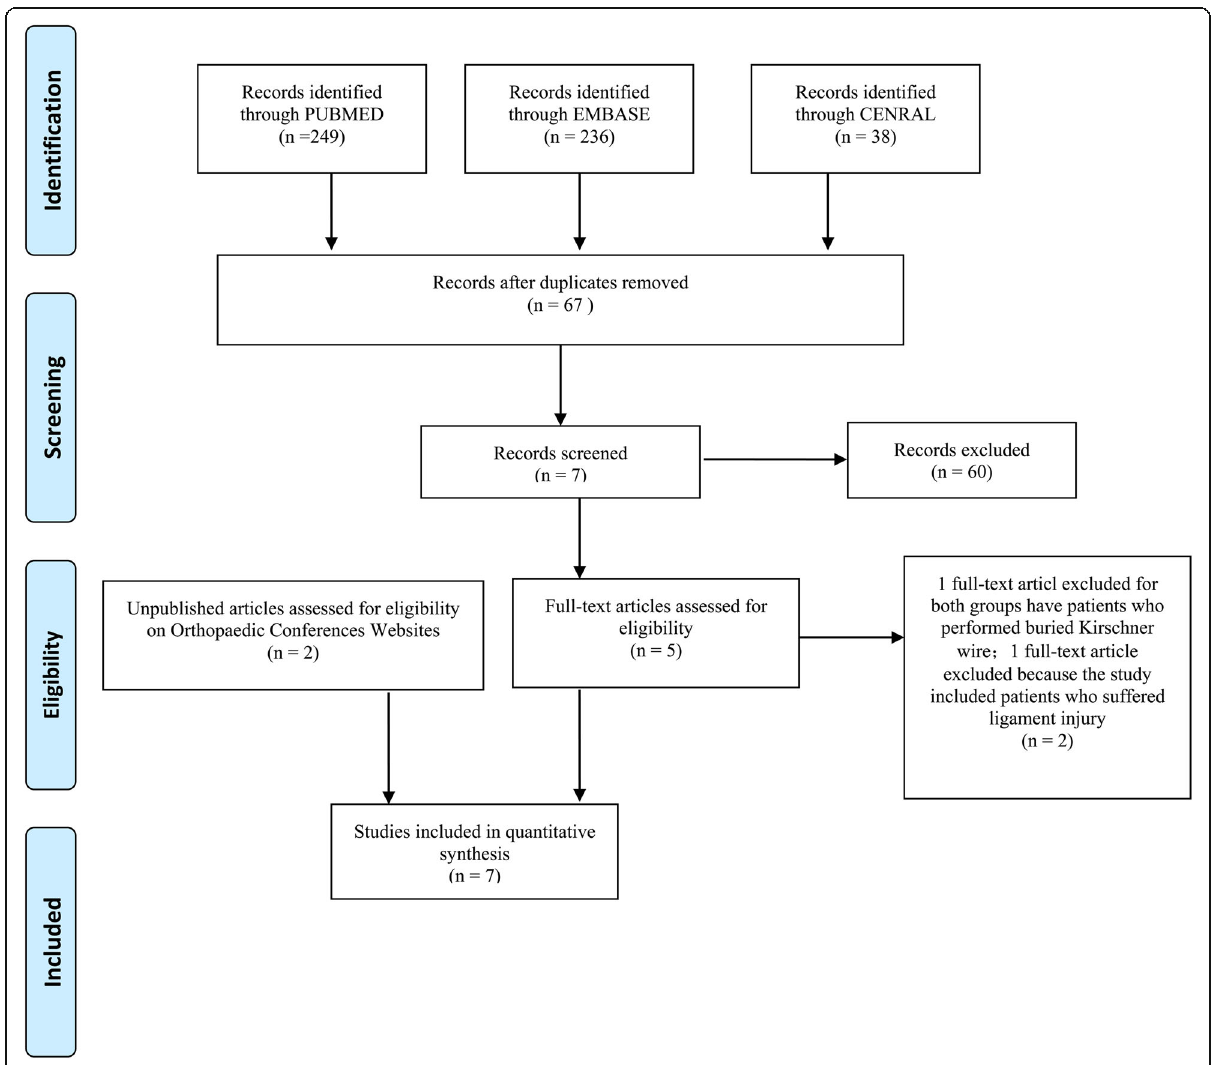
Fig. 1 Flow chart of selection of studies for inclusion in meta-analysis